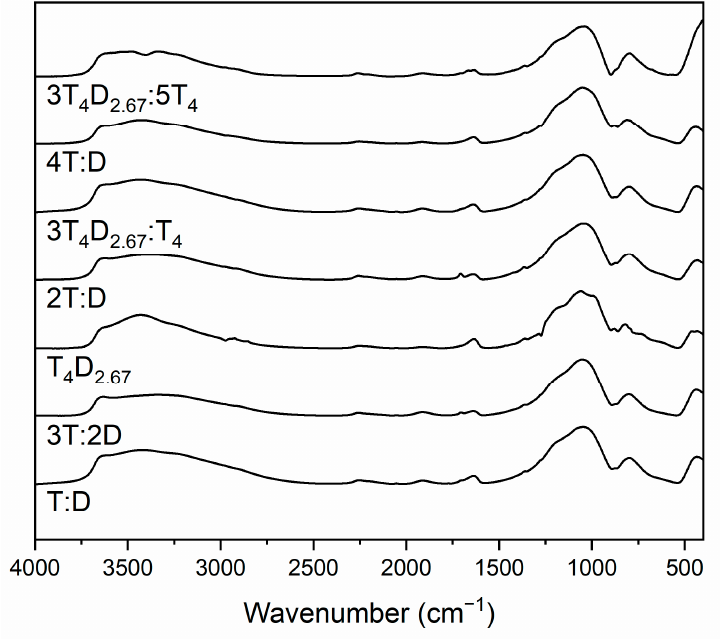
Figure 8. IR spectra of silicon-oxycarbide-based black glasses obtained from precursors after anneal- ing at 800 °C.